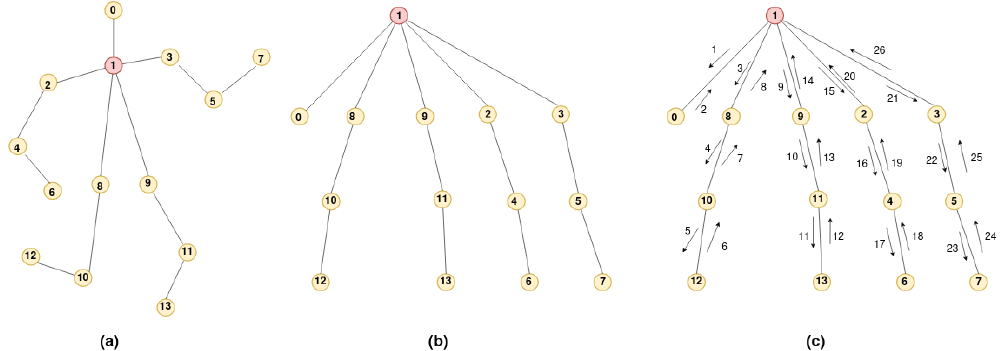
Figure 6. ( a ) Joints of the skeleton of a human body with the initial data structure. The visiting order of the nodes is incremental: 0-1-2-3-...-13. ( b ) The skeleton is transformed into a tree structure. ( c ) The tree can be unfolded into a chain in which the order of visit of the nodes maintains the physical relationship